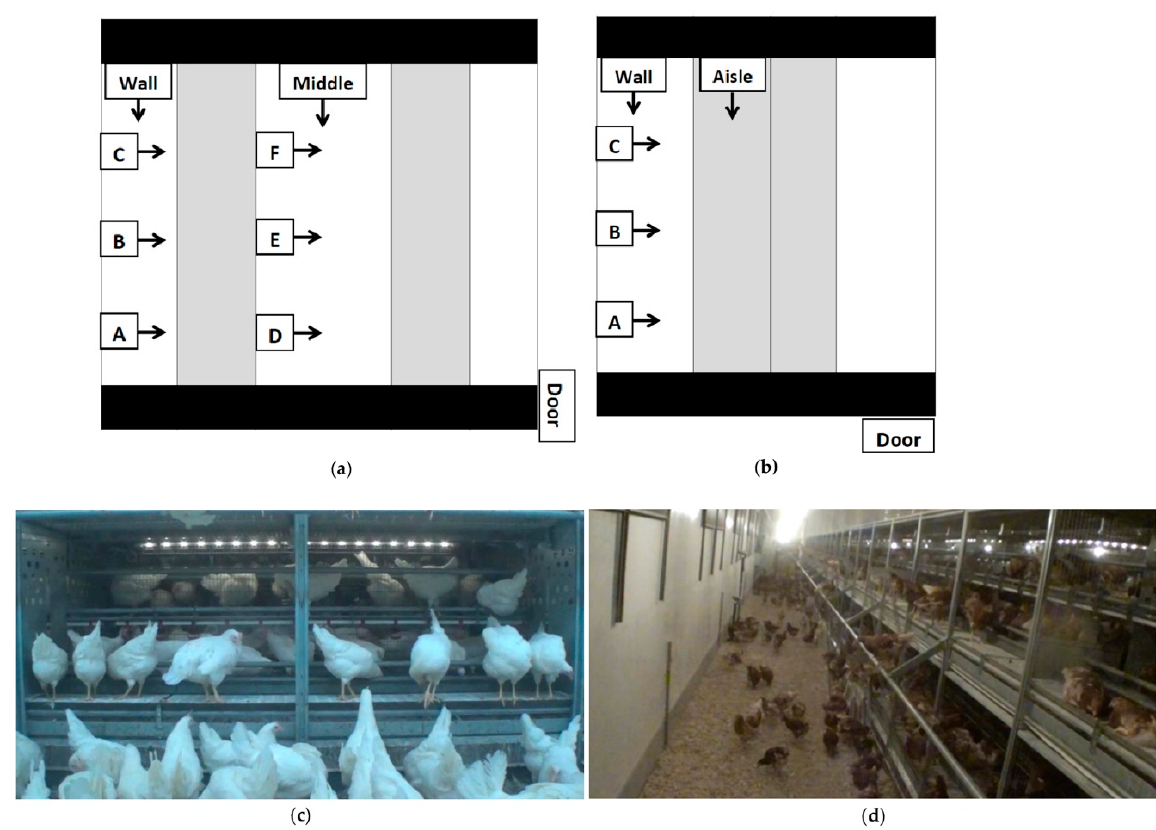
Figure 2. Aerial view of camera placements for (a) Style 1 and Style 2; (b) Style 3 rearing aviaries; (c) still shot from a low view into a Style 2 brooding compartment; (d) a still shot from a “wall” long view of a Style 2 rearing aviary. Blacked out areas are walkways for human traffic, unoccupied by pullets. The shaded sections are the aviary structures, and the white section is the litter area. Black lines separate rows of aviary structures. Cameras (represented by boxes) were located at the brooding compartment or panel section ¼ (A,D), ½ (B,E) and ¾ (C,F) down the aisle. At each letter location, one camera was positioned to view the litter floor and the bottom tier, and one viewed the top tiers of the system. Camera-labelled wall and middle viewed the litter area lengthwise. In style three, the camera-labelled aisle viewed the system lengthwise. Arrows indicate the direction in which cameras were facing.